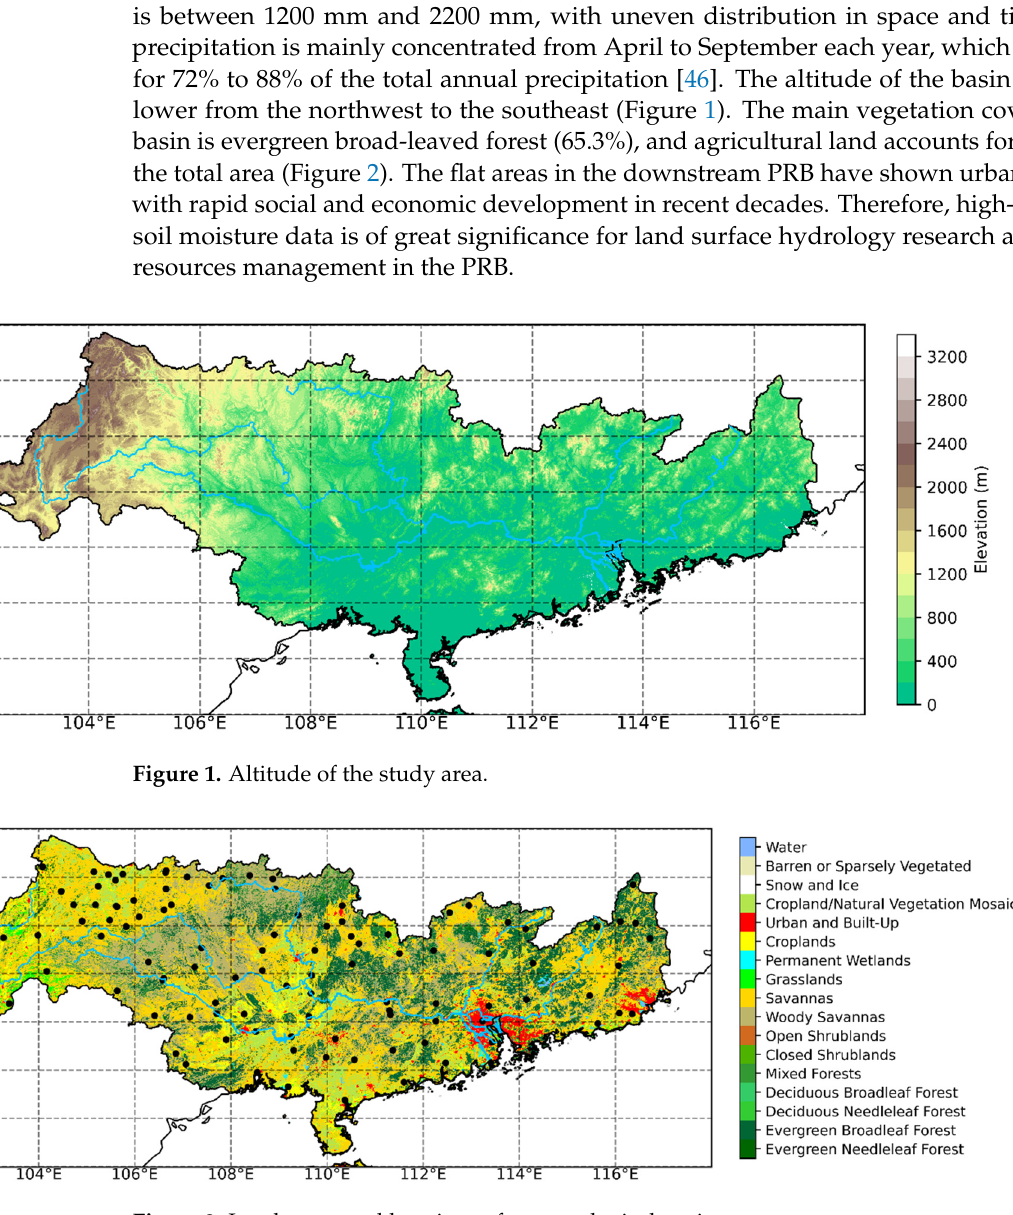
Figure 2. Land cover and locations of meteorological stations.